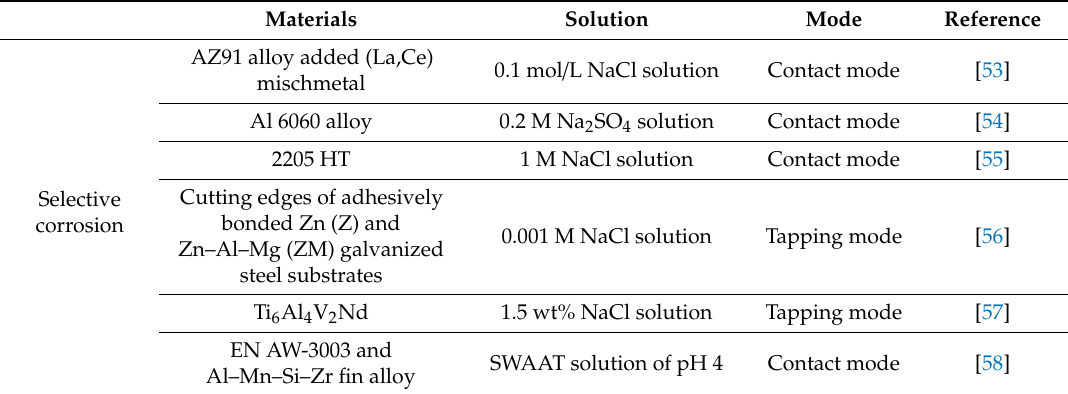
Table 4. Summary of the application of EC-AFM in selective